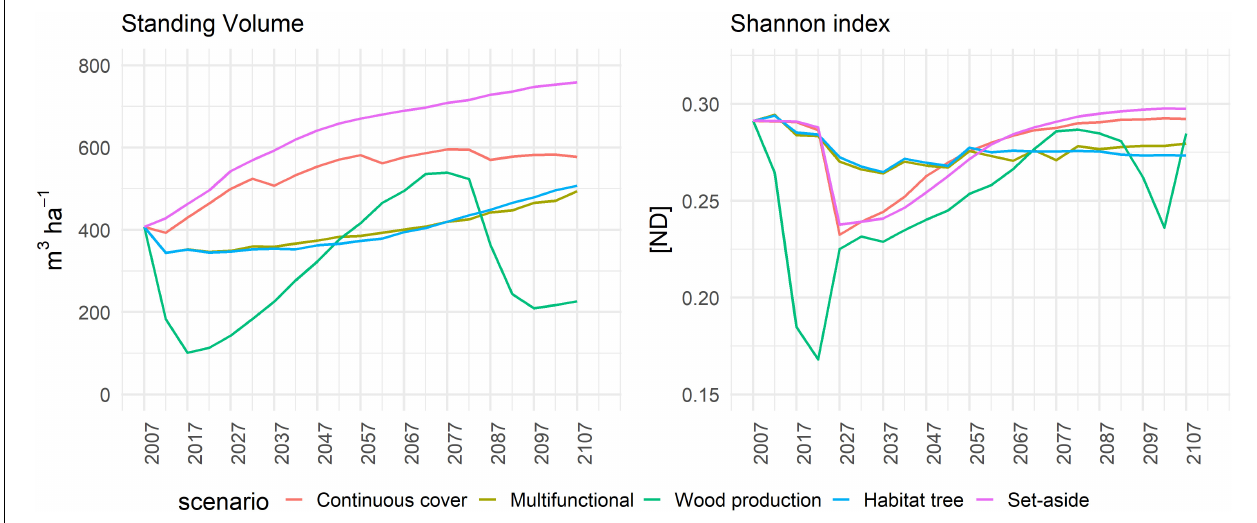
FIGURE 2 | Development of the standing volume (left) and the mean Shannon index for each scenario over